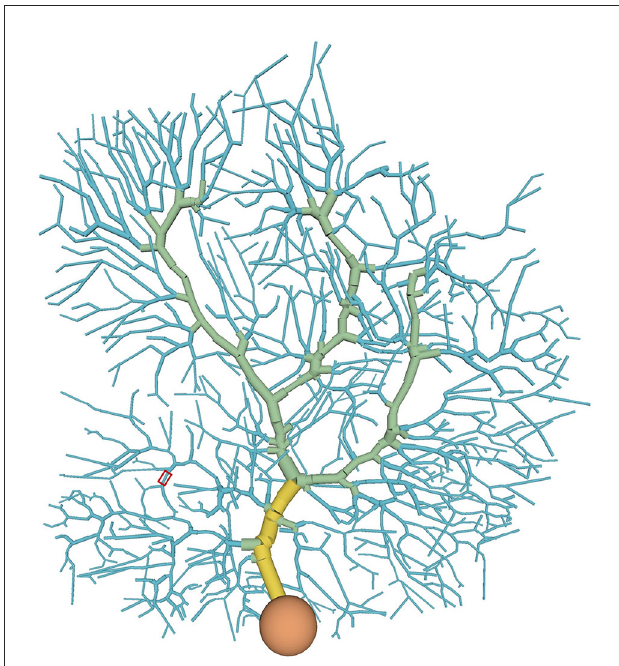
FIGURE1 Distribution of compartment types in the PC model: soma (orange), main dendrite (yellow), spiny dendrite (blue), and smooth dendrite (green). Each type has different ion channels. A typical stimulated site was shown in a red box (see also Figure